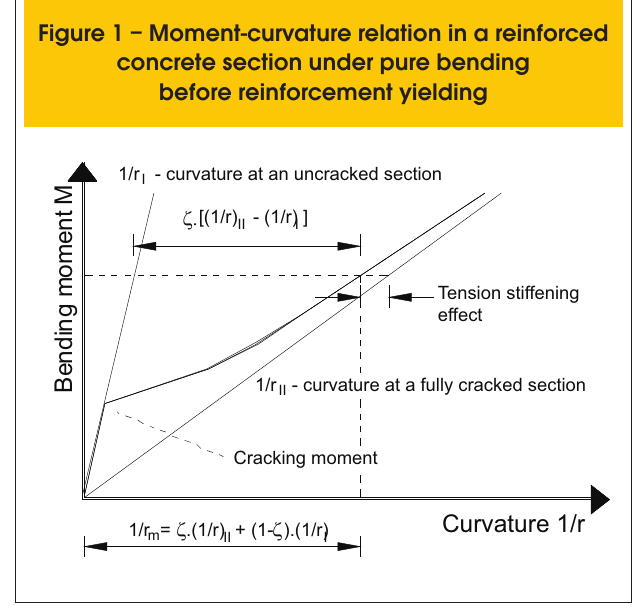
Figure 1 – Moment-curvature relation in a reinforced concrete section under pure bending